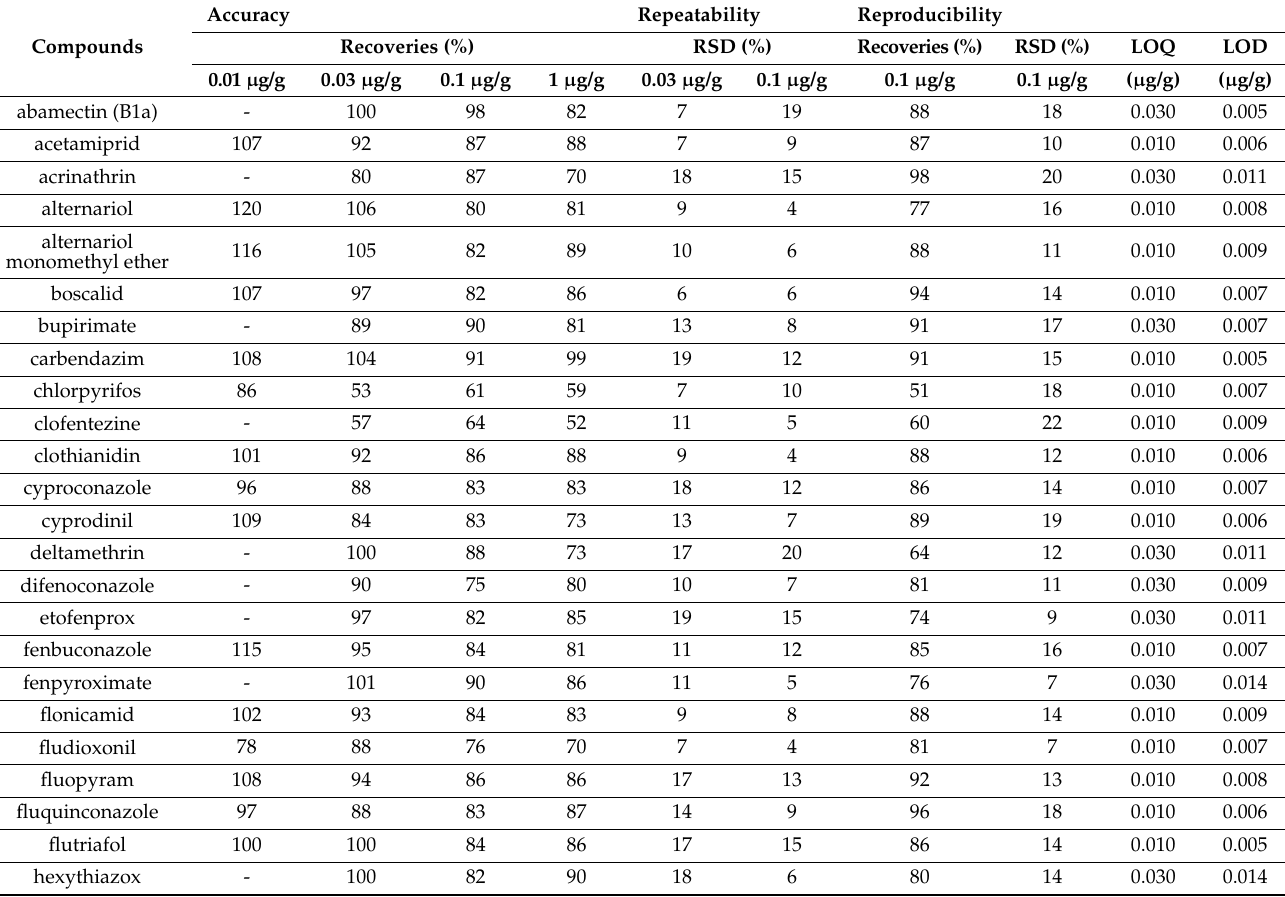
Table 1. Validation